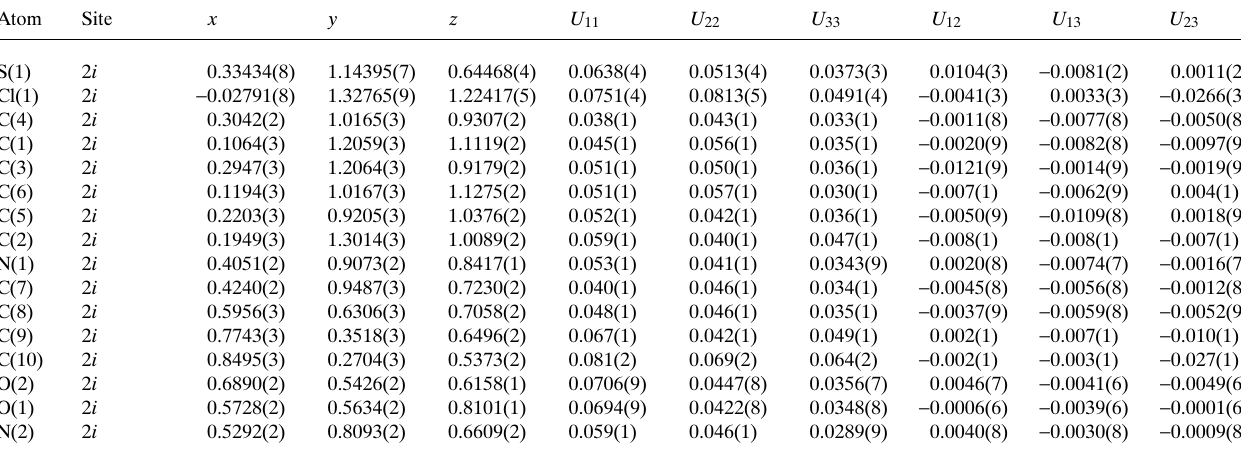
Table 3. Atomic coordinates and displacement parameters (in Å 2 ) .